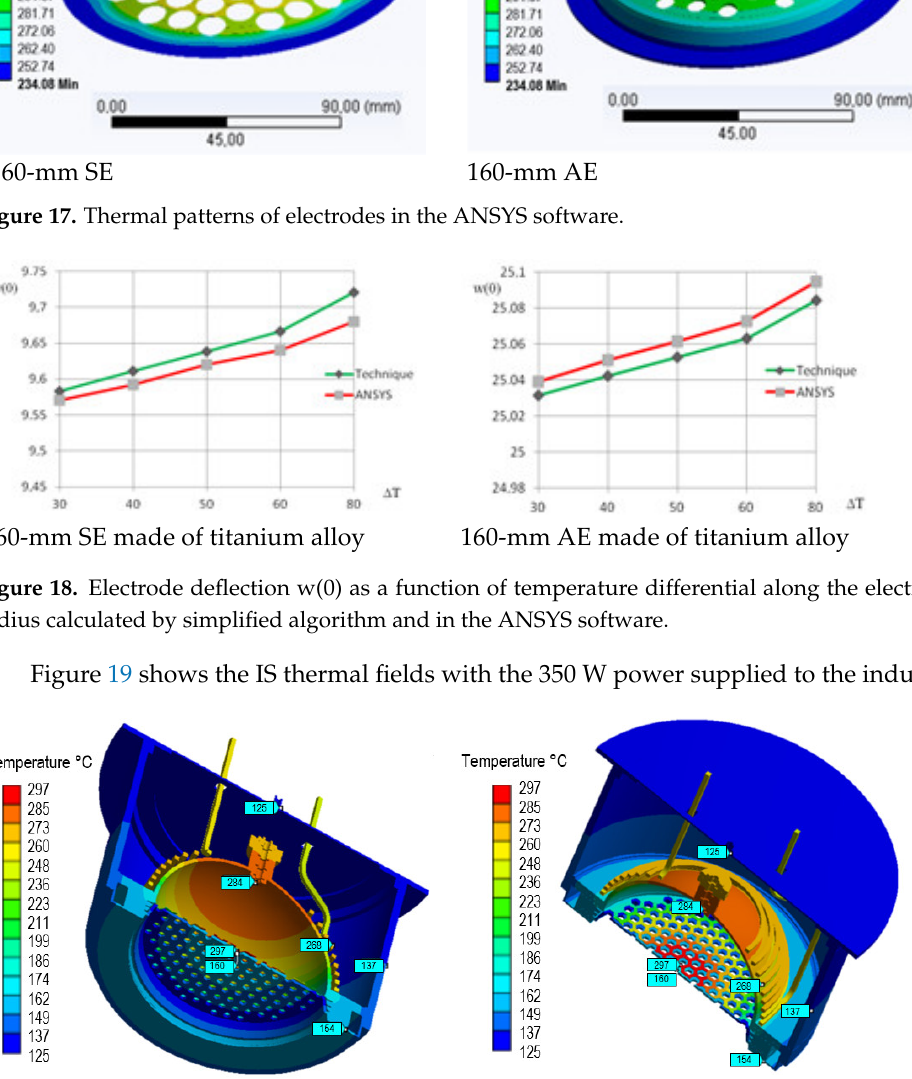
Figure 19. IS thermal fields with 350 W power supplied to the